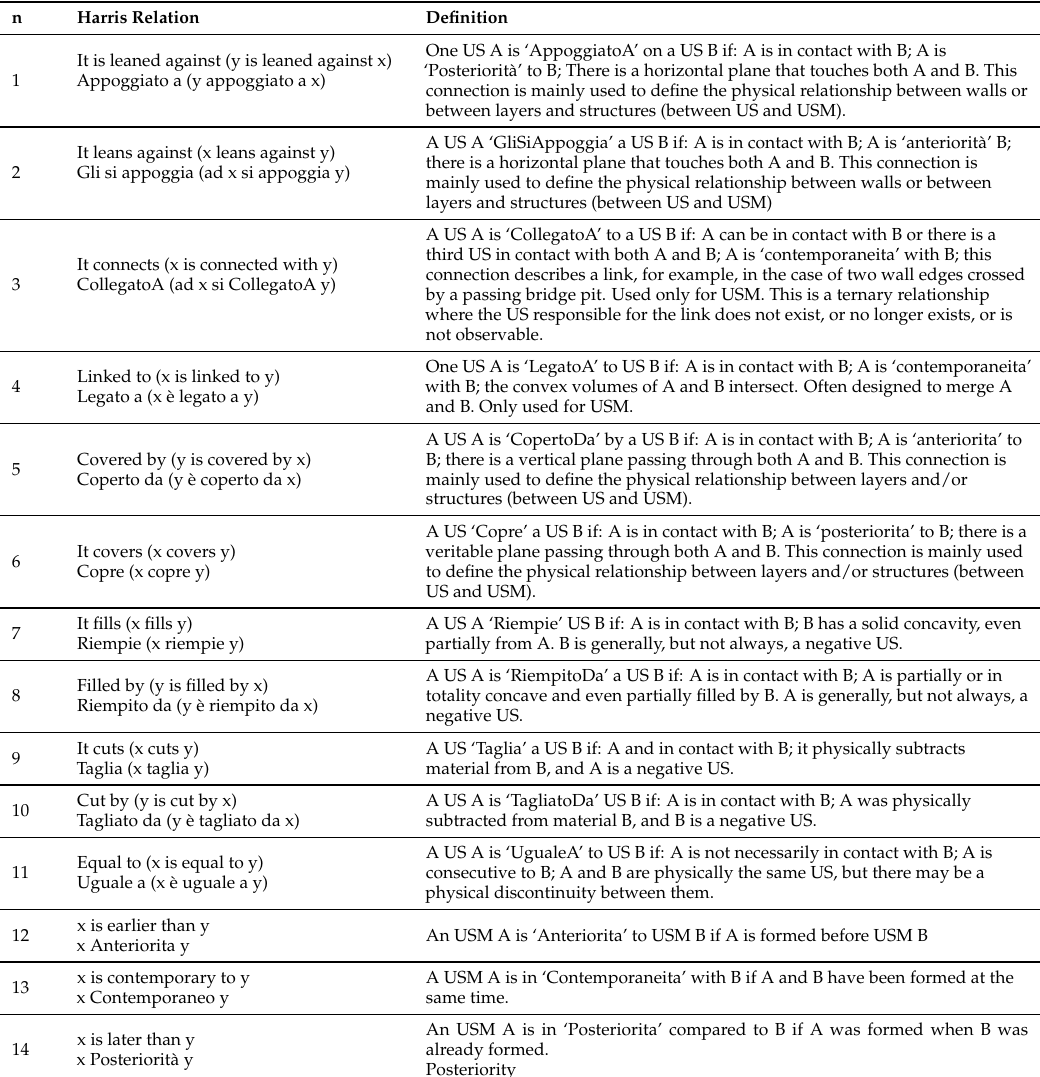
Table 5. Harris physical and temporal relation